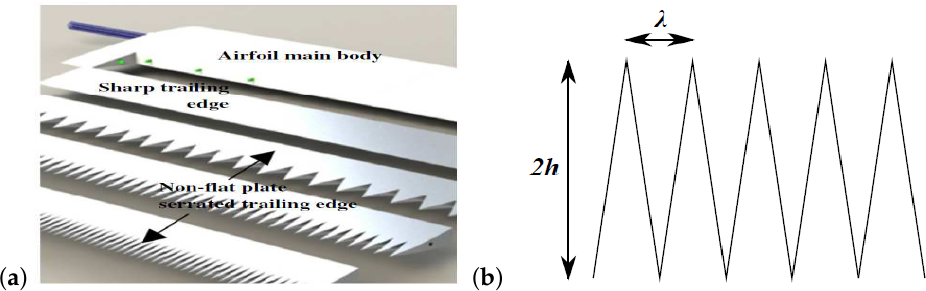
Figure 9. Trailing edge serrations: ( a ) CAD drawing of the NACA 0012 airfoil model with one sharp trailing edge and three non-flat plate serrated trailing edges (reprinted from [97] with permission from Elsevier); and ( b ) sketch of the trailing edge serrations with definition of wavelength λ and amplitude h